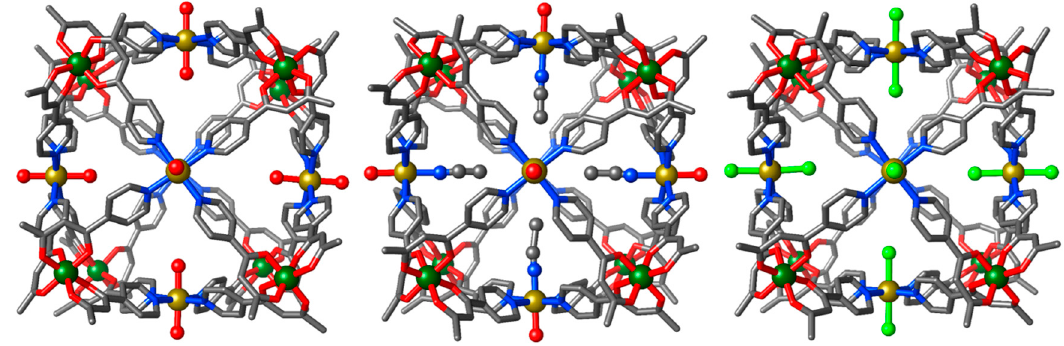
Figure 2. From left to right, molecular structures of ( 1 ), ( 2 ), and ( 3 ). Colour code: Cr III = green, Ni II = yellow, O = red, N = blue, Cl = light green, C = grey. H-atoms have been omitted for clarity.